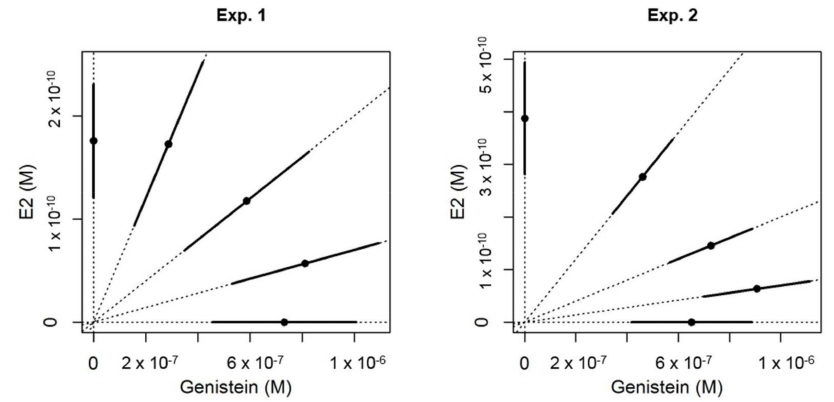
Figure 5. Illustration of the EC50 for each ray of the estradiol (E2) + genistein mixtures. The points represent the EC50 and the bars represent the standard error. These data originated from two independent exposure experiments with the cyp19a1b -GFP transgenic zebrafish line (described in Figure 4). The isobole is the line formed when EC50s of each ray are joined. A straight isobole would indicate additivity. The deviation of the isobole to the right indicates an